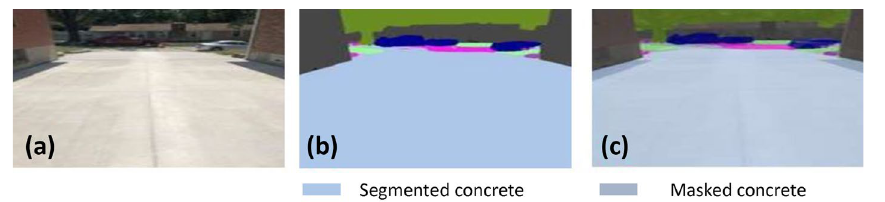
Figure 12. Offline results: concrete.